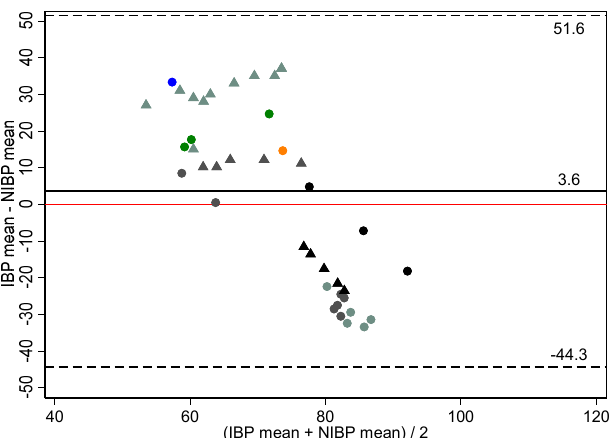
Figure 3. Bland–Altman plot of agreement for 41 paired mean arterial blood pressure measurements (mm Hg) made non-invasively compared to those made invasively using the Bionet BM7Vet in 9 healthy, anaesthetised horses. The non-invasive arterial blood pressure cuff was placed at the metacarpus. Repeated observations from the same horse are plotted using the same colour-shape combination. The solid black line indicates mean bias, and the dashed lines indicate lower and upper limits of agreement. The solid red line represents zero bias. IBP invasive blood pressure, NIBP non-invasive blood pressure. Bias defines accuracy.